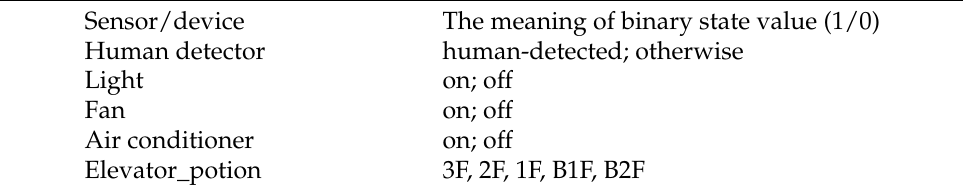
Table 1. Data value examples of the unified